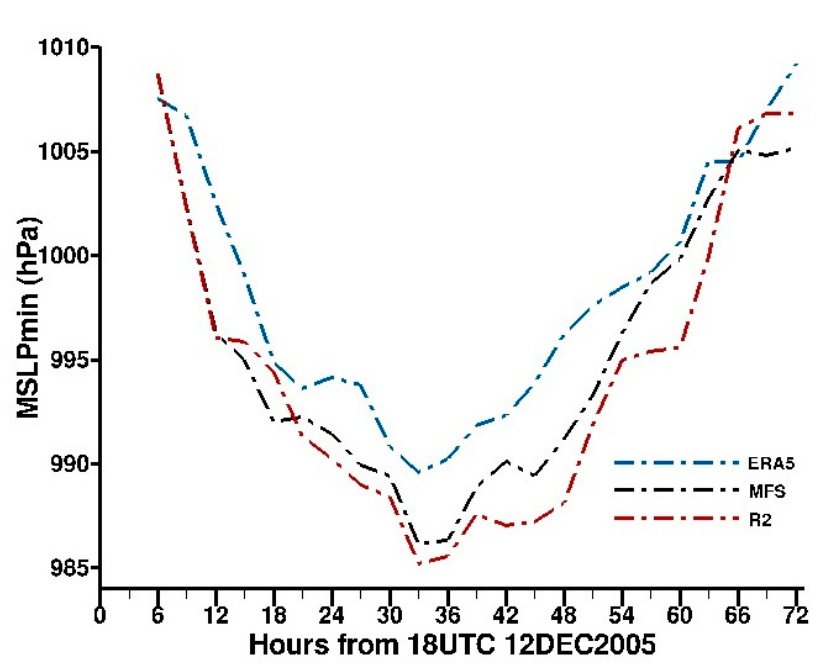
Figure 11. Time series of the minimum MSLP (hPa) for the ERA5 reanalysis (blue), R2 run (red) and MFS run (black).